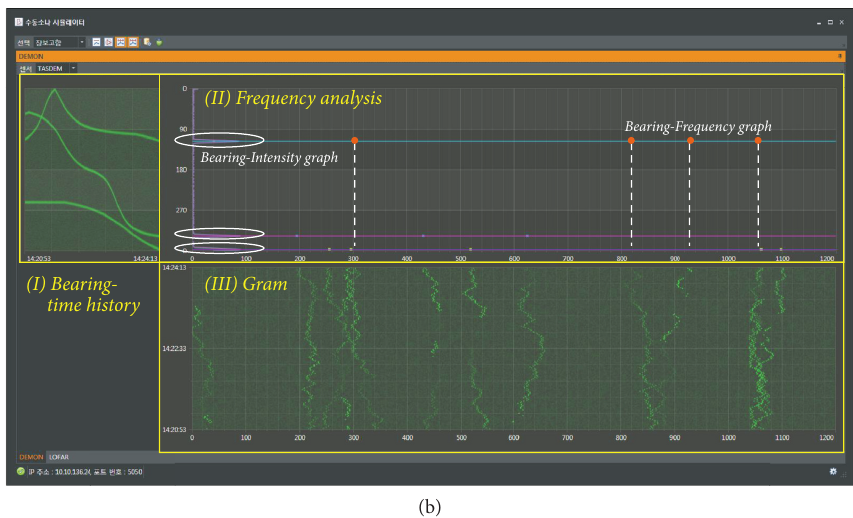
Figure 9: GUIs of the sonar simulator with two views: (a) broadband view; (b) narrowband